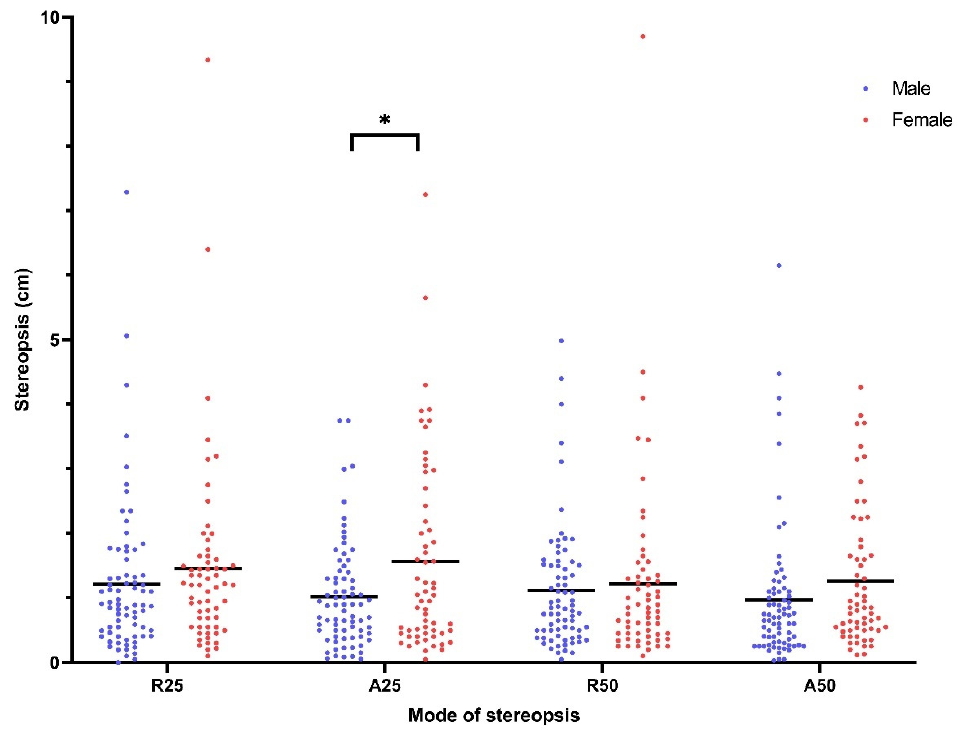
Figure 1. Stereopsis of male and female college students measured in four modes of stereopsis. (*: statistical significant between males and females)